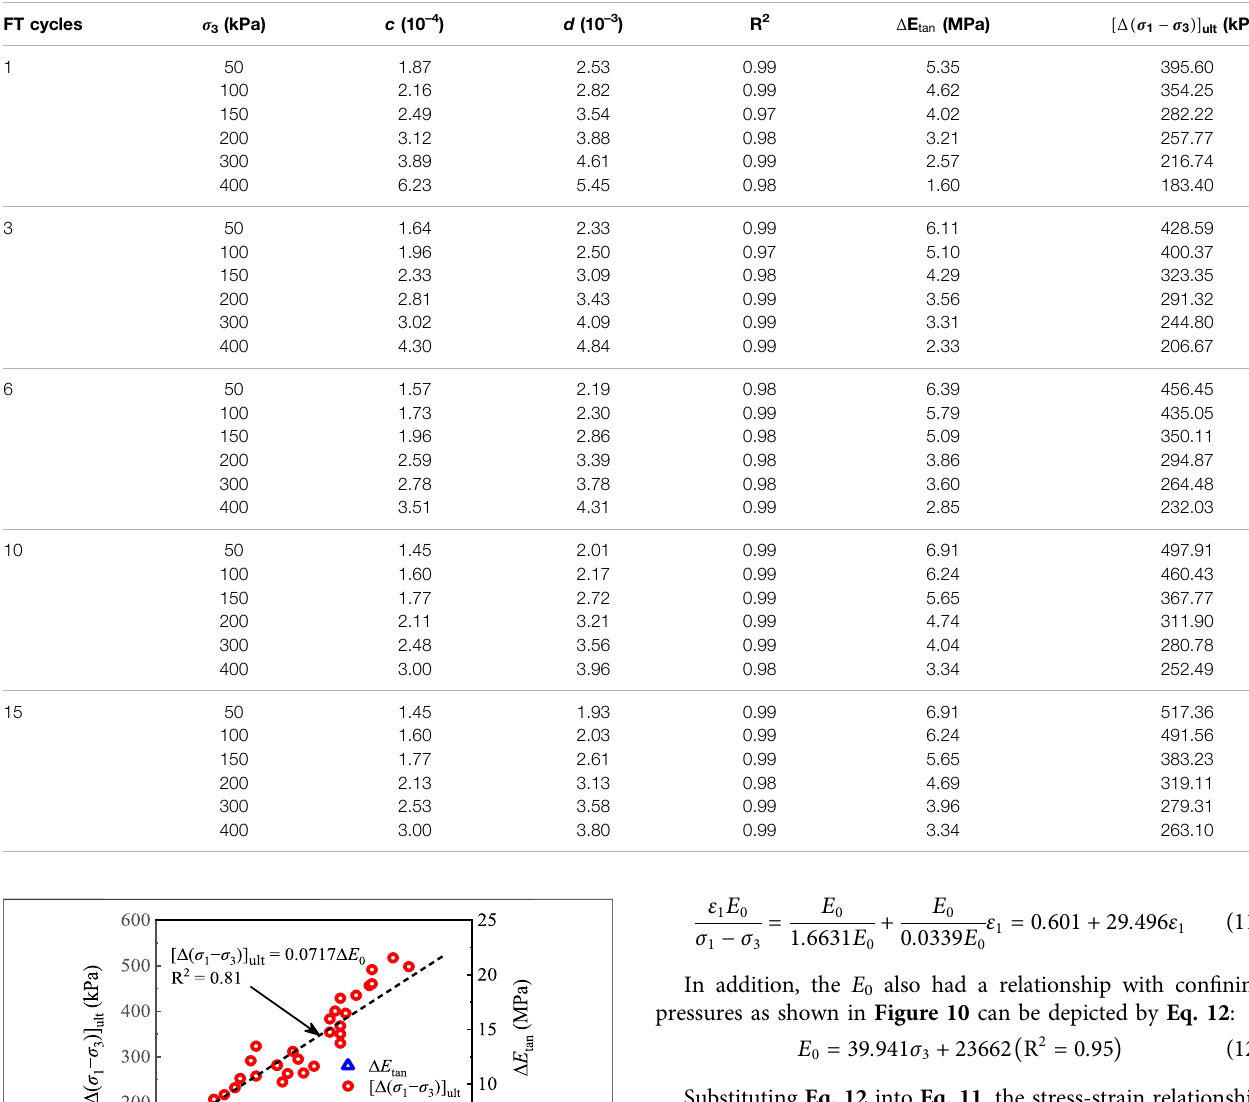
TABLE 5 | Results of the Konder model for the deviator stress differences. FT